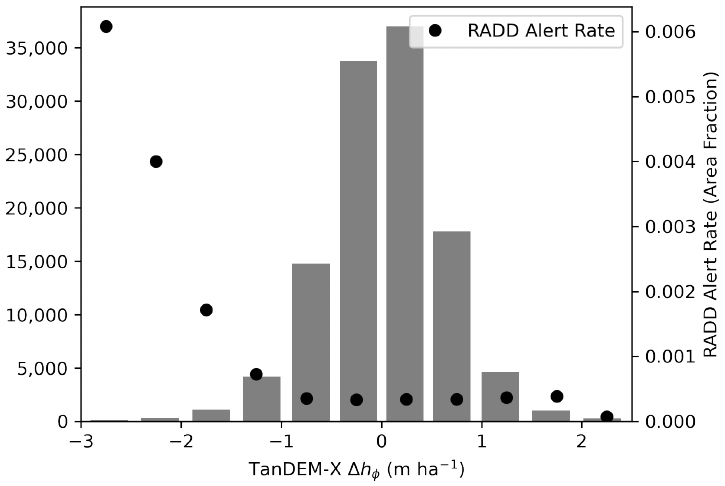
Figure 13. RADD forest disturbance alert rate (area of alerts in the first half of 2020 divided by total area) is shown as black dots, binned by magnitude of TDX h φ change. The total area in each bin is indicated by the bar chart. Alert levels increase with the magnitude of degradation predicted by